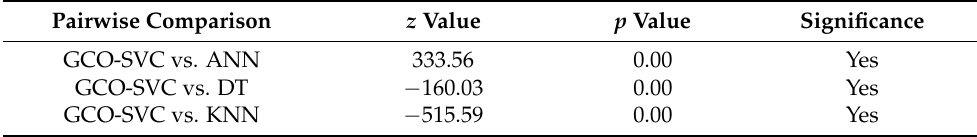
Table 7. Pairwise comparison results for the seven models using the Wilcoxon signed-rank